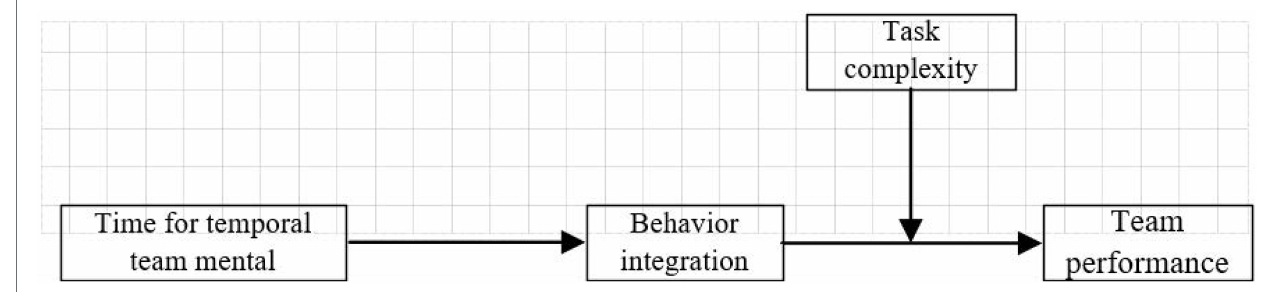
FIGURE 1 | Theoretical